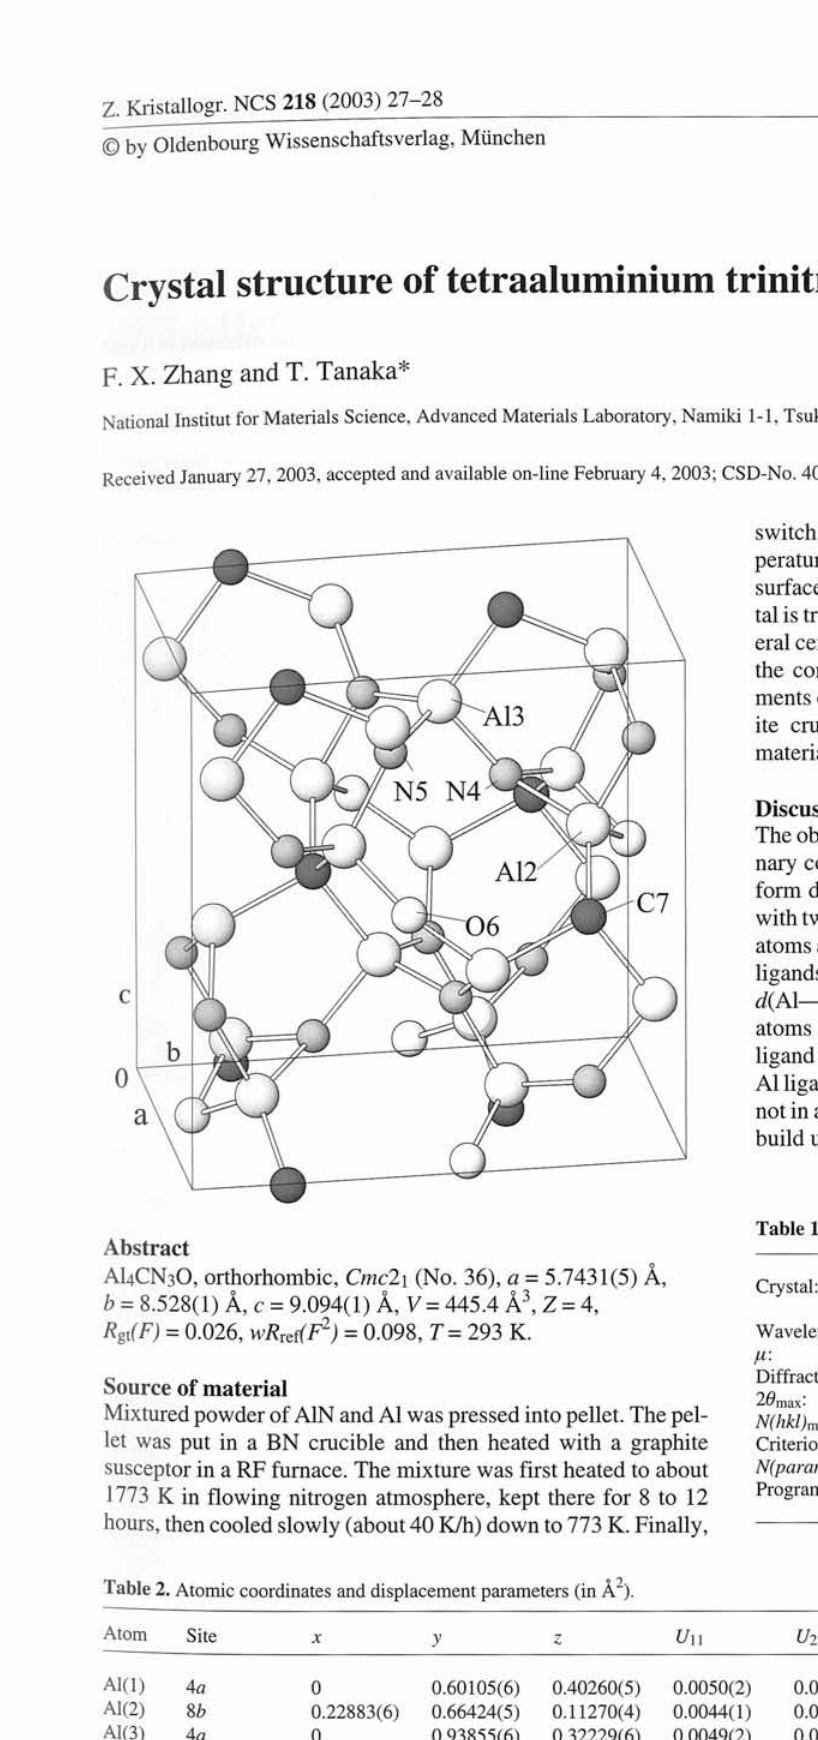
Table 2. Atomic coordinates and displacement parameters (in Â 2